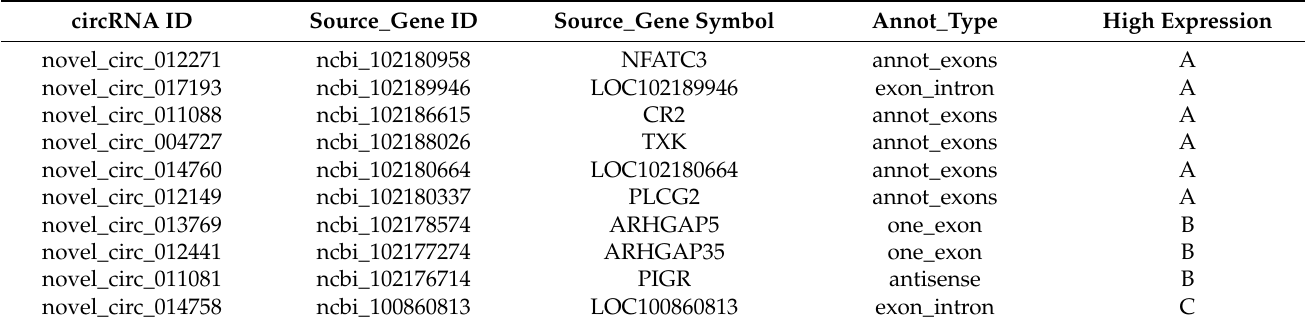
Table 8. Immune-related circRNA information.